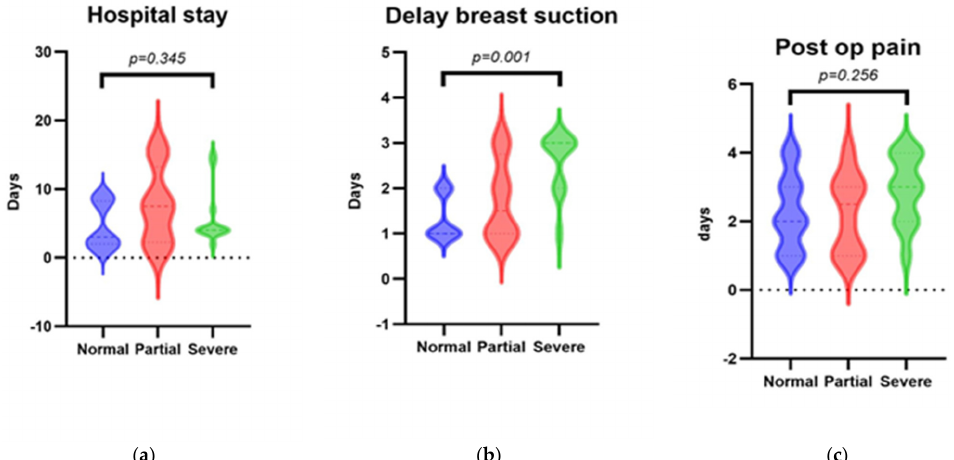
Figure 2. Post operative outcomes analysis divided for healing subtypes. In the Kruskal − Wallis test, a statistical significance was demonstrated only for delay in breast suction according to healing outcomes ( p = 0.001).